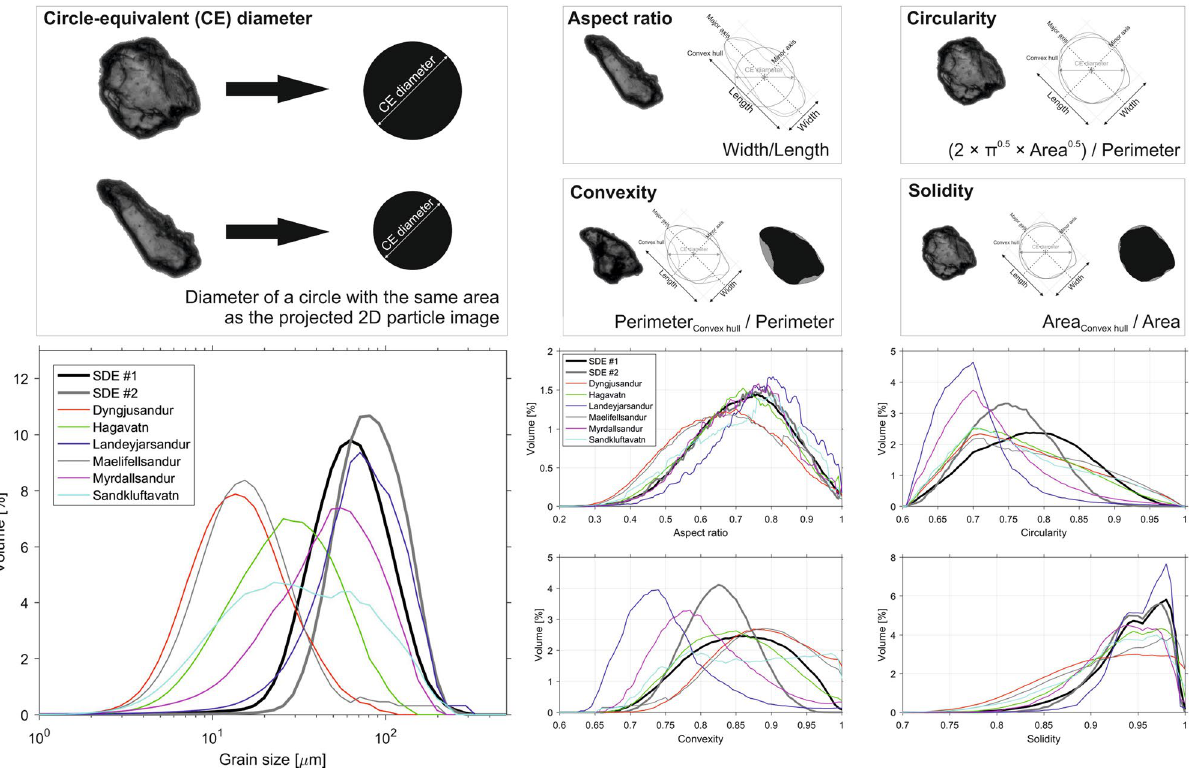
Figure 5. Distribution curves of the grain size and shape of bulk samples from SDEs and Icelandic source